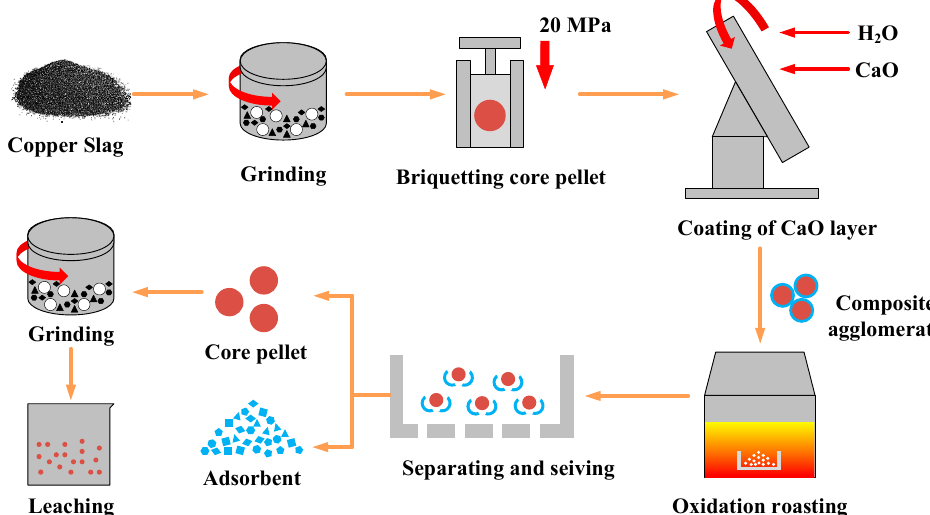
Figure 2. Schematic diagram of oxidation roasting-separation-leaching